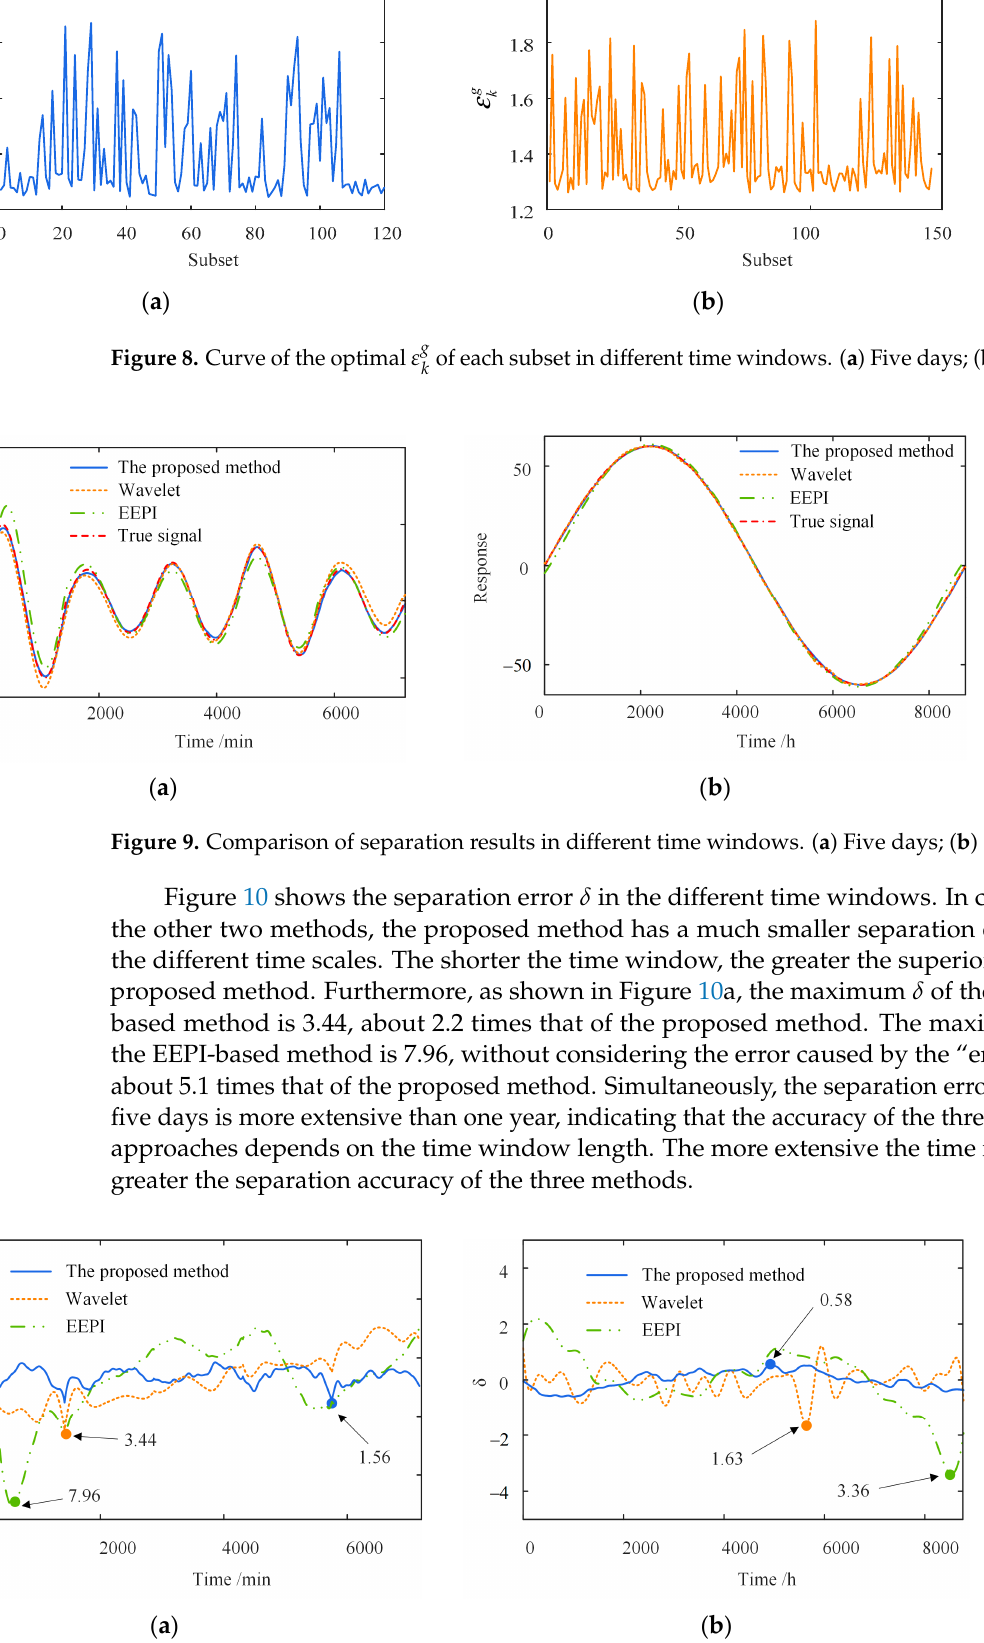
ε of each subset in different time windows. ( a ) Five days; ( b ) one k